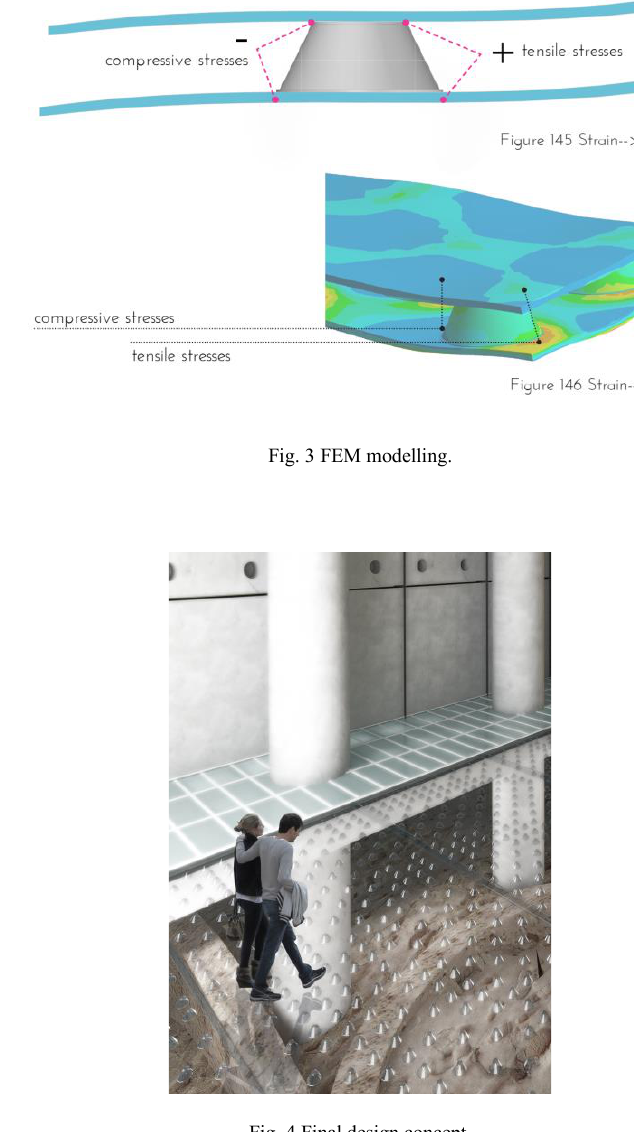
Fig. 4 Final design